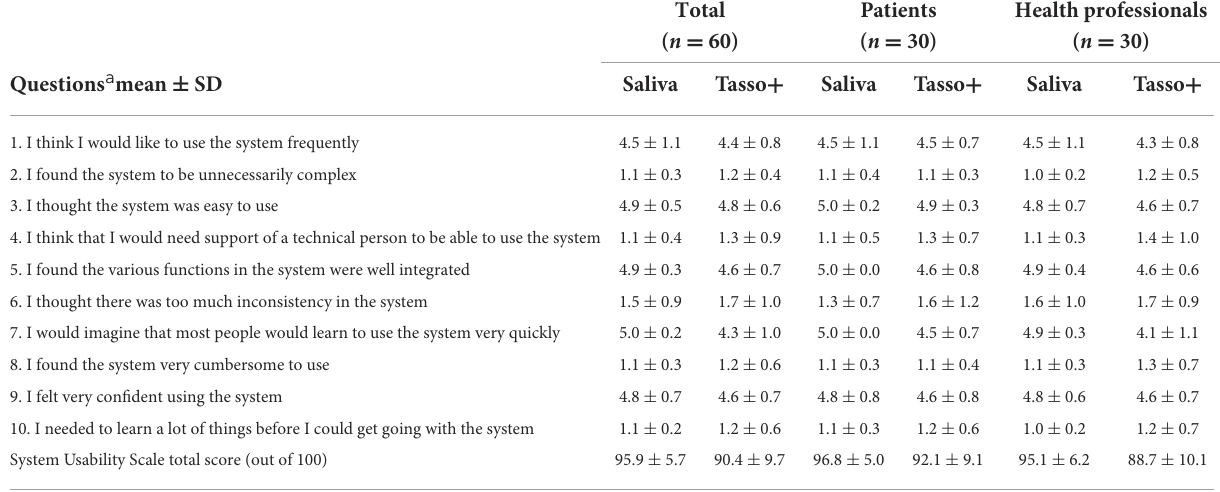
TABLE 2 Means and standard deviation scores for the System Usability Scale.